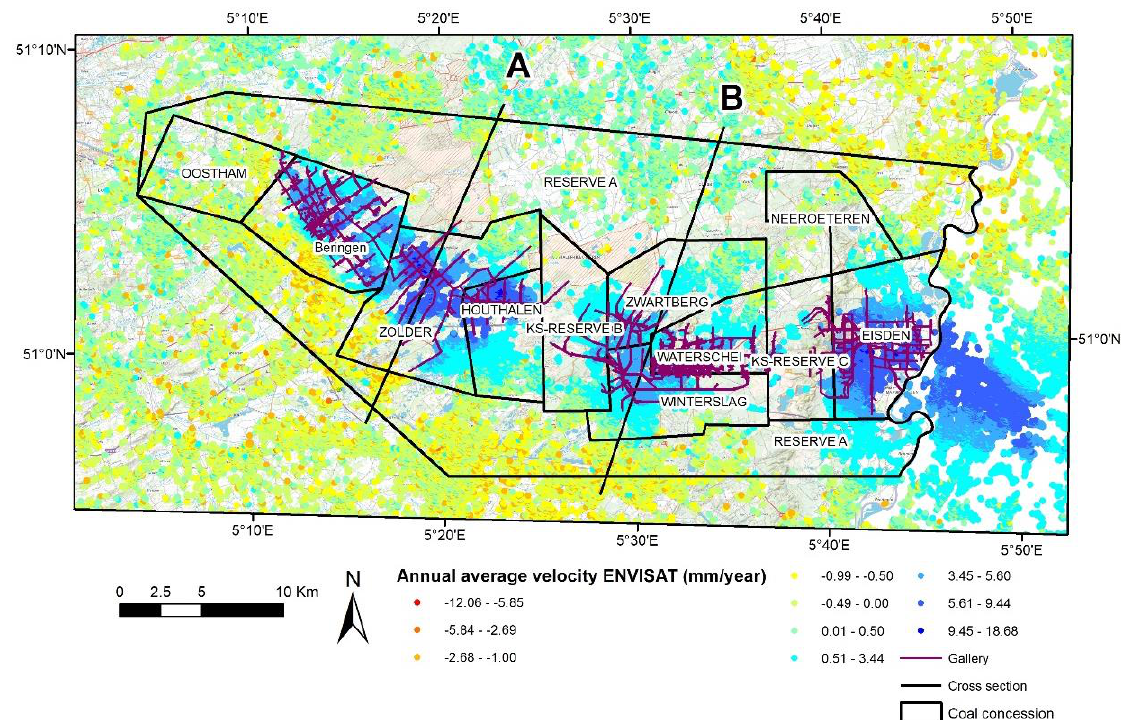
Figure 13. Color classification based on the average annual LOS velocities of PS points for ENVISAT (2003 – 2010), superimposed with the extension of coal concessions in Limburg, the location of the mine galleries, and the position of the two cross sections, A and B.